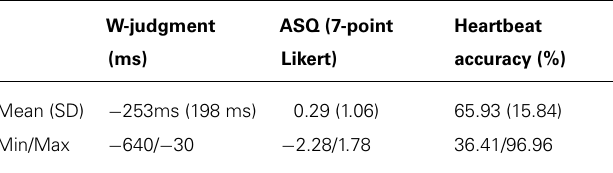
Table 1 | Descriptive statistics forW-judgment,AS score and heartbeat accuracy.